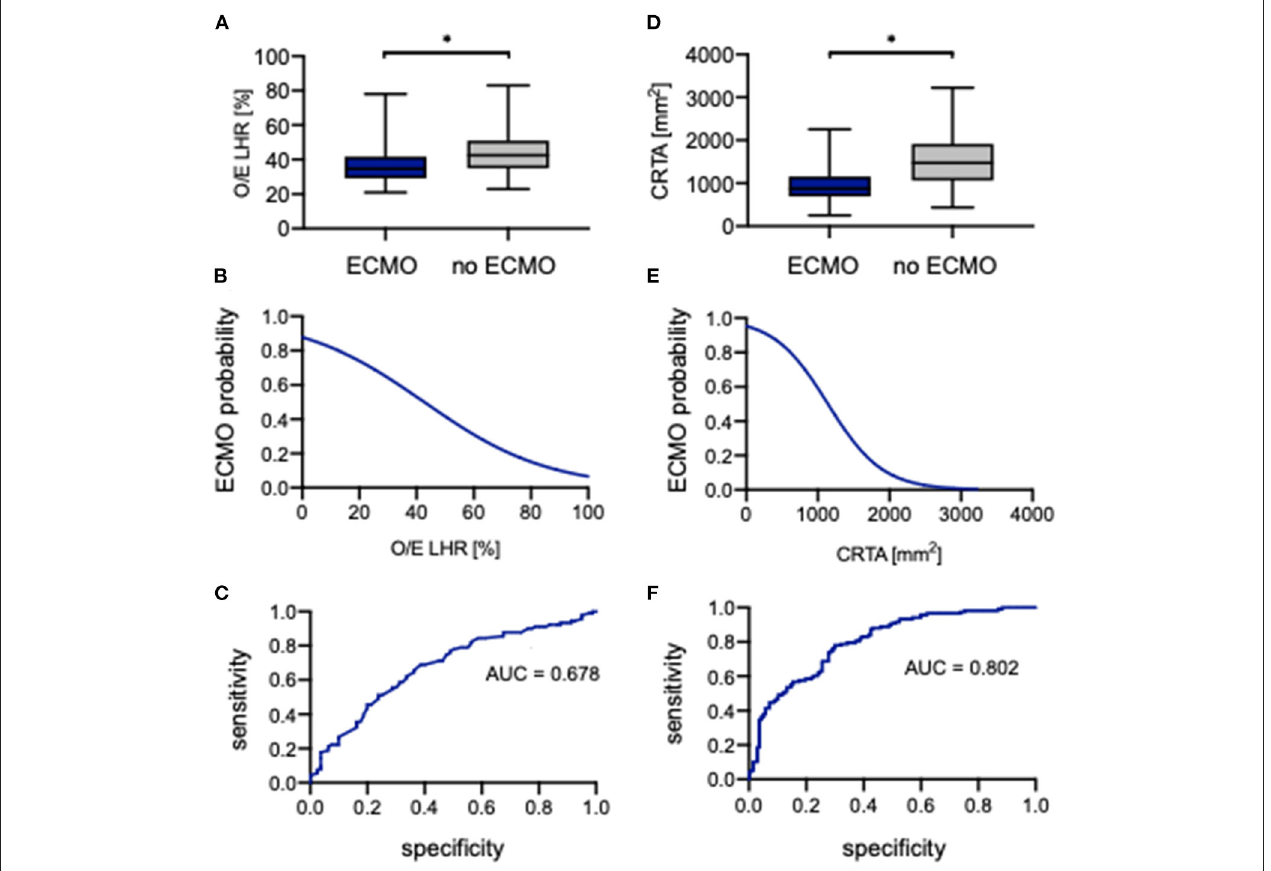
FIGURE 5 | Correlation of observed-to-expected lung-to-head ratio and CRTA to ECMO. Boxplots of (A) observed-to-expected lung-to-head ratio and (D) CRTA are exhibited for patients with ECMO and without ECMO support (whiskers are shown as minimum and maximum). Also shown is the logistical regression (B,E) and ROC curve (C,F) of observed-to-expected lung-to-head ratio and CRTA for the prediction of ECMO probability in the study population. *Significant difference in the U test. AUC, area under curve; CRTA, chest radiographic thoracic area; ECMO, extracorporeal membrane oxygenation; LHR, lung-to-head ratio; O/E,